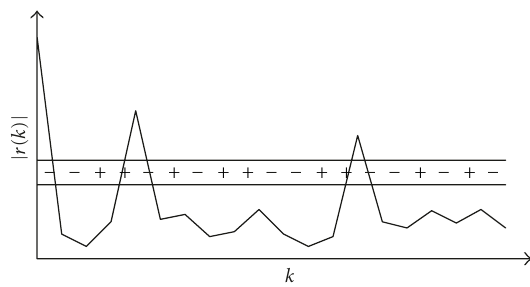
Figure 3: Peak detection algorithm based on positive and negative